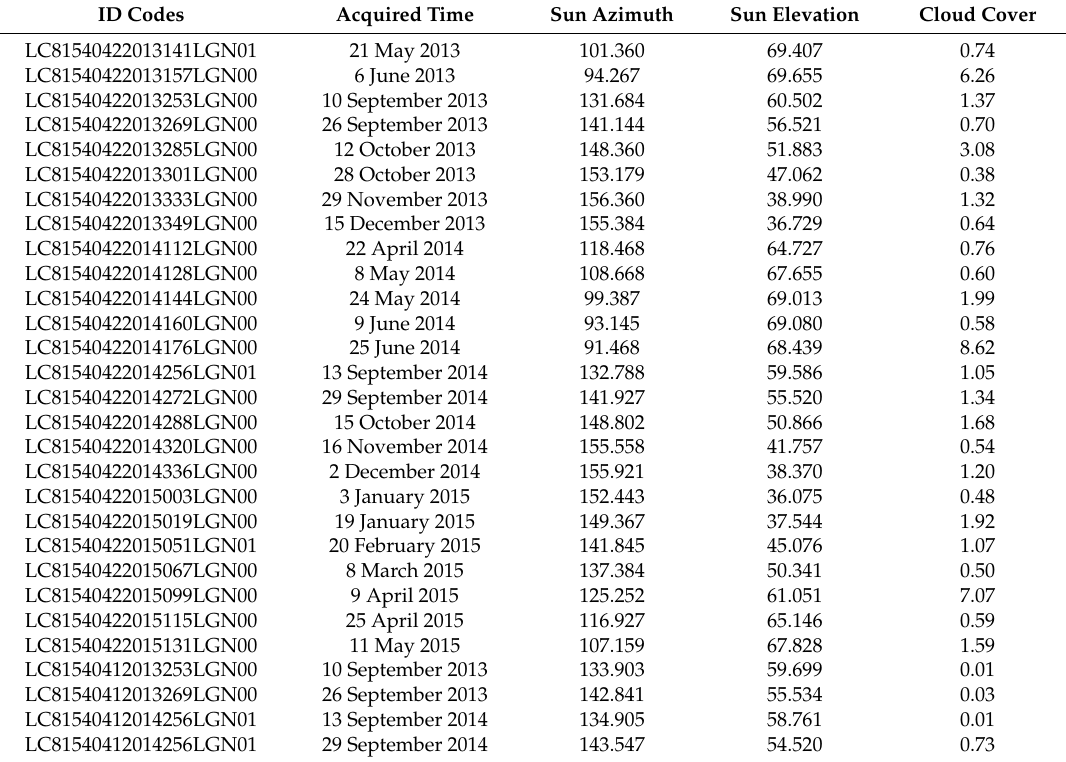
Figure A1. Matching distribution of 16 correlation pairs using 25 Landsat 8 panchromatic images, following the uniform temporal standard of 16 days. Table A1. Parameters catalog of Landsat 8 OLI Pan images used in the study.